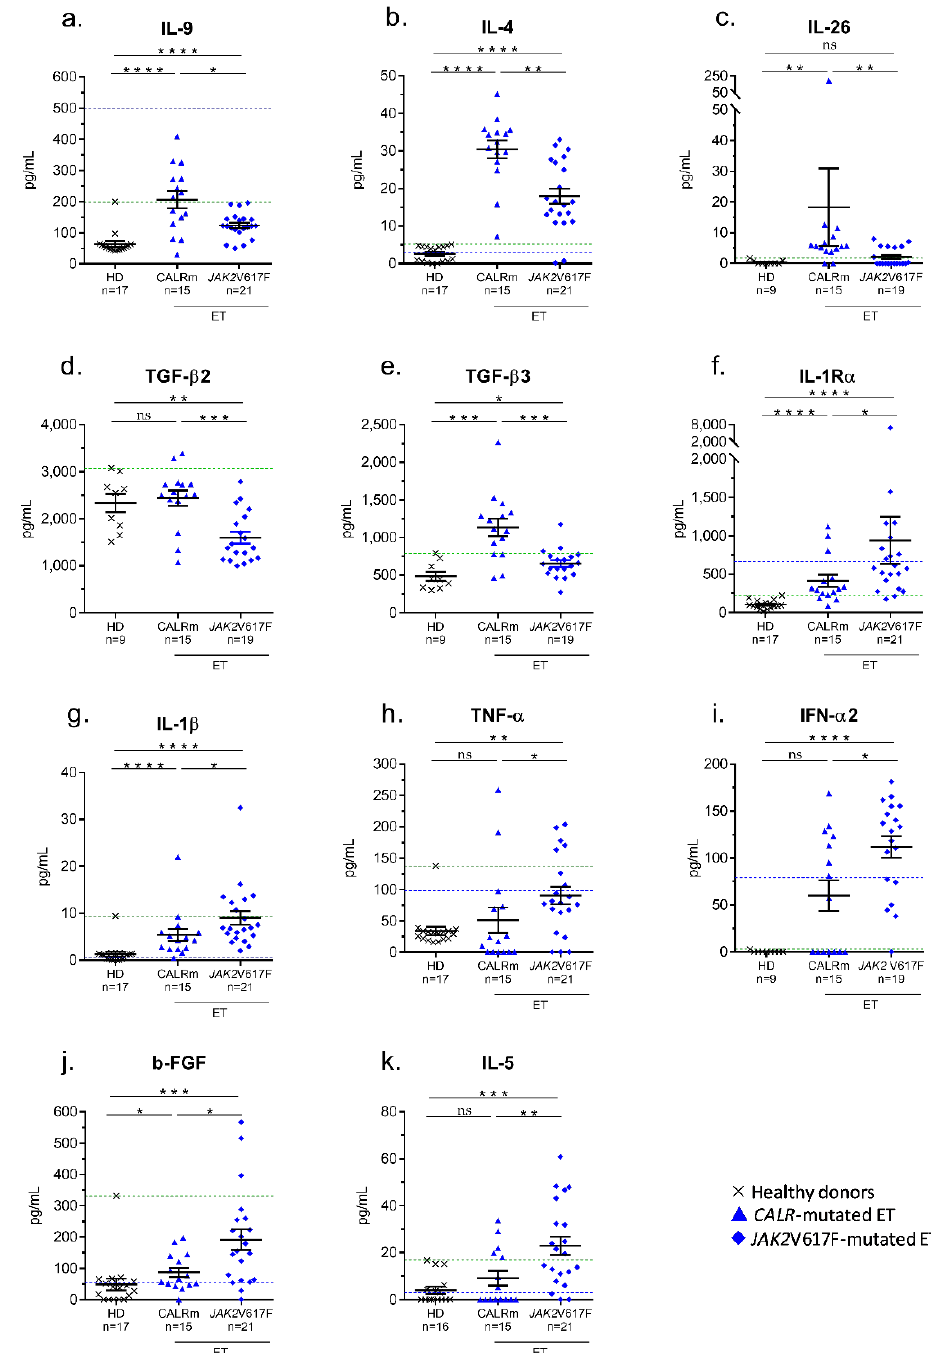
Figure 3. Differences in cytokine levels in CALR - and JAK2 V617F-mutated ET . Significant differences were found between CALR - and JAK 2V617F- mutated ET for 9 cytokines: ( a ) IL-9; ( b ) IL-4; ( c ) IL-26; ( d ) TGF- β 2 ; ( e ) TGF- β 3 ; ( f ) IL-1R α ; ( g ) IL-1 β ; ( h ) TNF- α ; ( i ) IFN- α 2 ; ( j ) b-FGF; ( k ) IL-5. Results are presented as the means + SEM; note the changes in scales (Y axis). (*) p < 0.05, (**) p < 0.01, (***) p < 0.001 and (****) p < 0.0001, Mann–Whitney t -test. Dotted blue lines represent the upper normal values for healthy individuals according to the manufacturers of the BioPlex Pro-human Cytokine kits, measured in 66 healthy donors. Dotted green lines represent the upper normal values for healthy individuals as measured in our control cohort of 17 healthy donors.